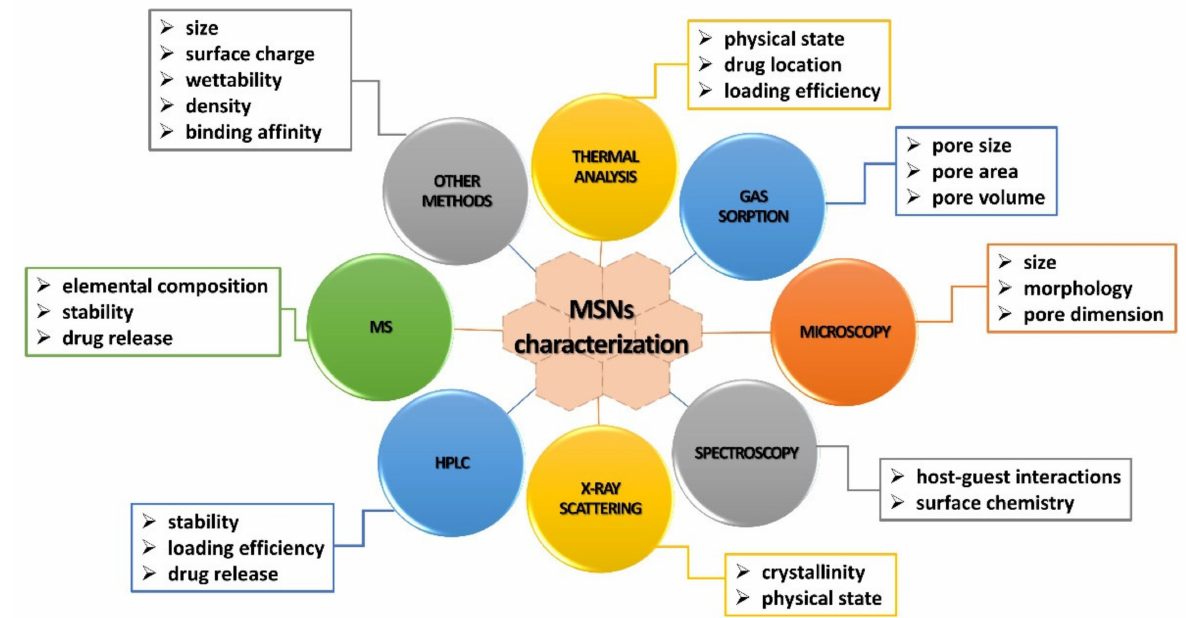
Figure 5. Different groups of analytical techniques used for MSNs